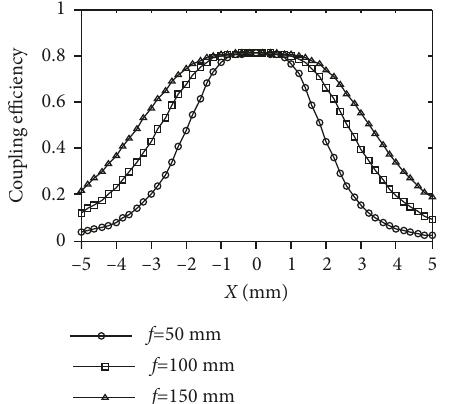
Figure 4: The coupling efficiency versus transverse distance and lens focal length.